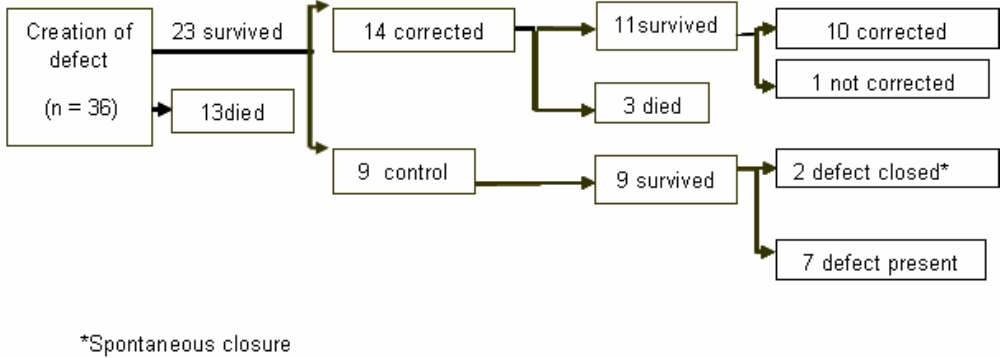
FIGURE 2 - Survival and success rates after intrauterine creation (75 days) and correction (100 days) of MMC-like defects in fetal sheep